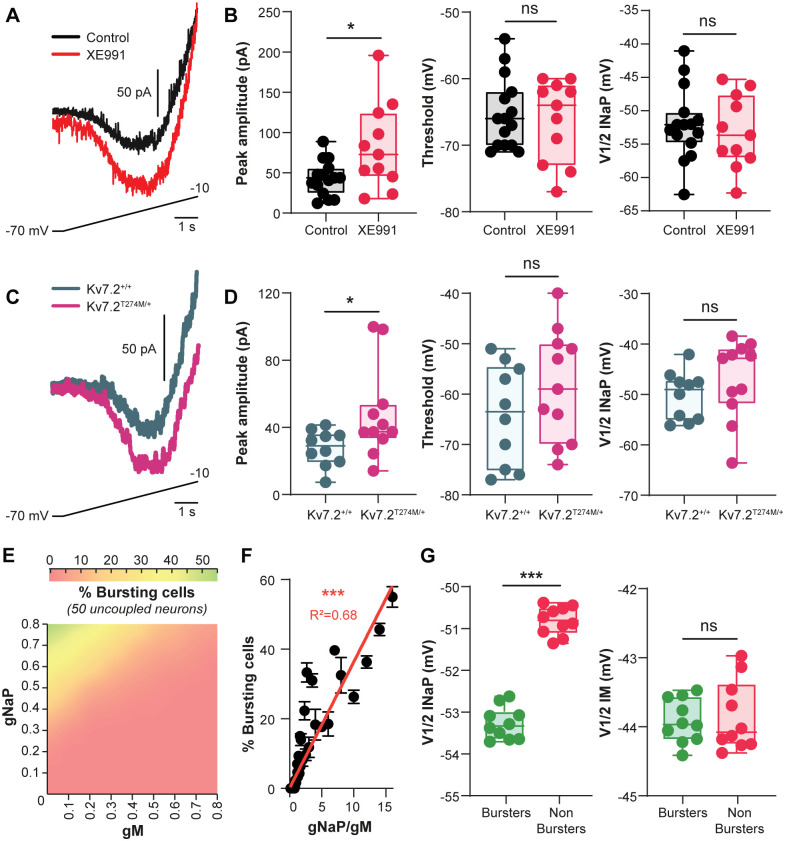
A balance of IM and INaP gates bursting mode of CPG interneurons.(A,C) Raw traces of leak-subtracted persistent sodium current (INaP) evoked in L1–L2 ventromedial interneuron by a slow voltage ramp and recorded from neonatal rats (A) under control condition (n = 15 cells, black) or in the presence of XE991 (10 μM, n = 11 cells, red) or from neonatal mice (C) wild-type (n = 10 cells, gray) and Kv7.2Thr274Met/+ mutant mice (n = 11 cells, pink). (B,D) Boxplot quantification of the biophysical properties of INaP. *P < 0.05; Mann–Whitney test. (E) Dependence of the percentage of bursting pacemaker cells on gM and gNaP in the heterogeneous population model of 50 neurons. Results are pooled from 10 simulations. (F) Percentage of bursting cells as function of the gNaP/gM ratio. Each dot represents average values of 10 simulations for a fixed gNaP/gM ratio. Continuous line is the best-fitting linear regression. ***P < 0.001, Spearman correlation test. R2 indicates the correlation index. (G) Boxplot quantification of V1/2 of INaP and IM for burster and nonburster groups. Each dot represents 1 simulation in the heterogeneous population model of 50 neurons. Parameters values for gNaP and gM were set at 0.8 nS and 0.1 nS, respectively. ***P < 0.001; Mann–Whitney test. Underlying numerical values can be found in the S1 Data. CPG, central pattern generator; XE991, 10,10-bis(4-pyridinylmethyl)-9(10H)-anthracenone dihydrochloride.